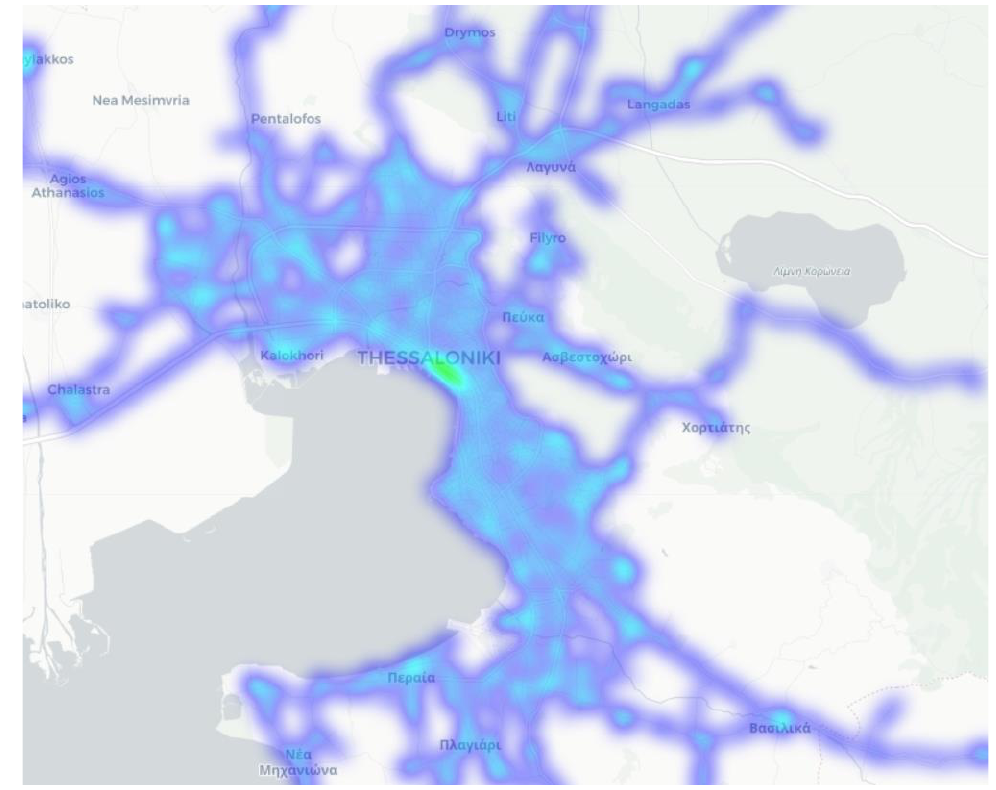
Figure 2. Spatial distribution of recorded GNSS points on metropolitan area of Thessaloniki.